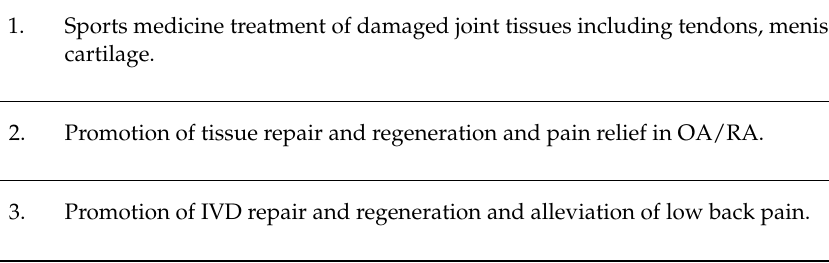
Table 3. Established and potential new areas of therapeutic application for